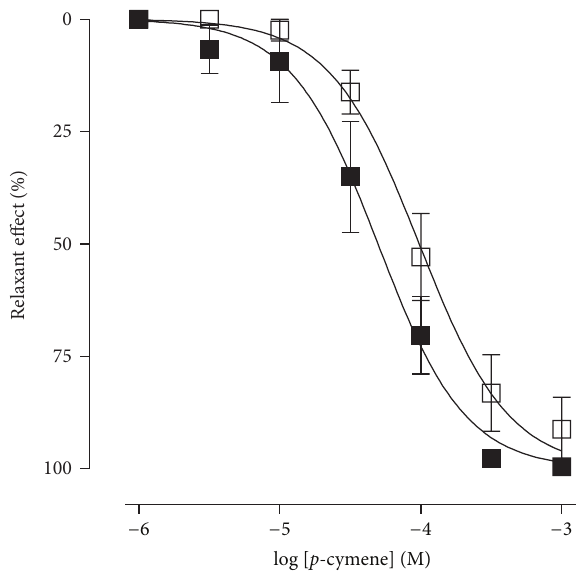
Figure 3: Relaxant effect of p -cymene on the isolated rat aortic rings contracted by phenylephrine with ( ◼ ) and without ( ◻ ) endothelium.